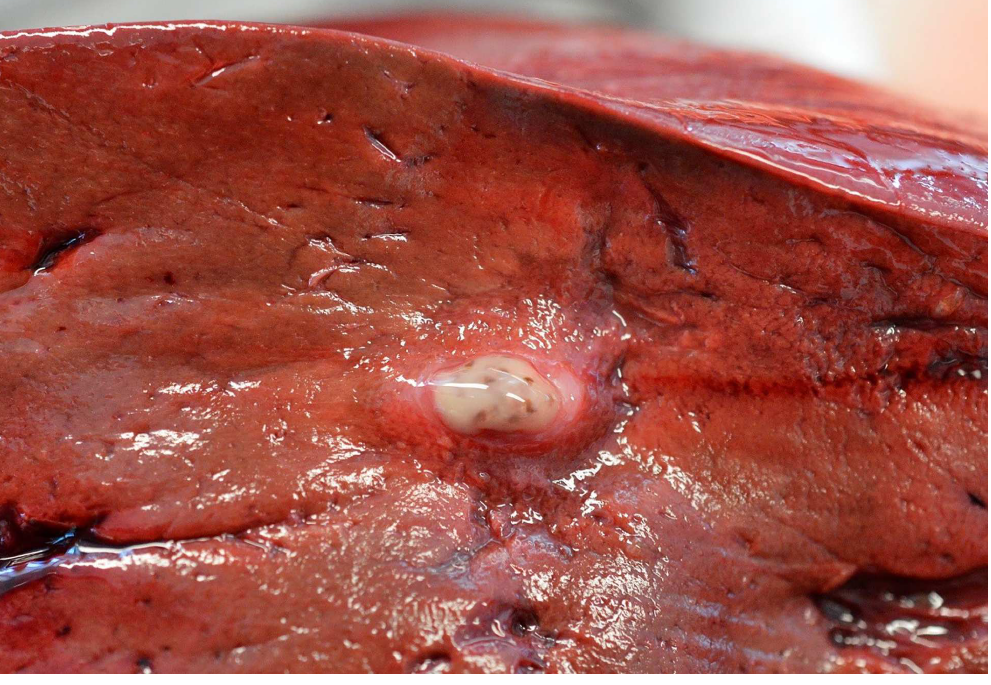
Fig 3. Cross section of the liver of a grey seal ( Halichoerus grypus ) with a mild, localized infection of Pseudamphistomum truncatum . Note the ectatic bile duct filled with beige exudate admixed with small, brown trematode parasites centrally. Bile duct walls are